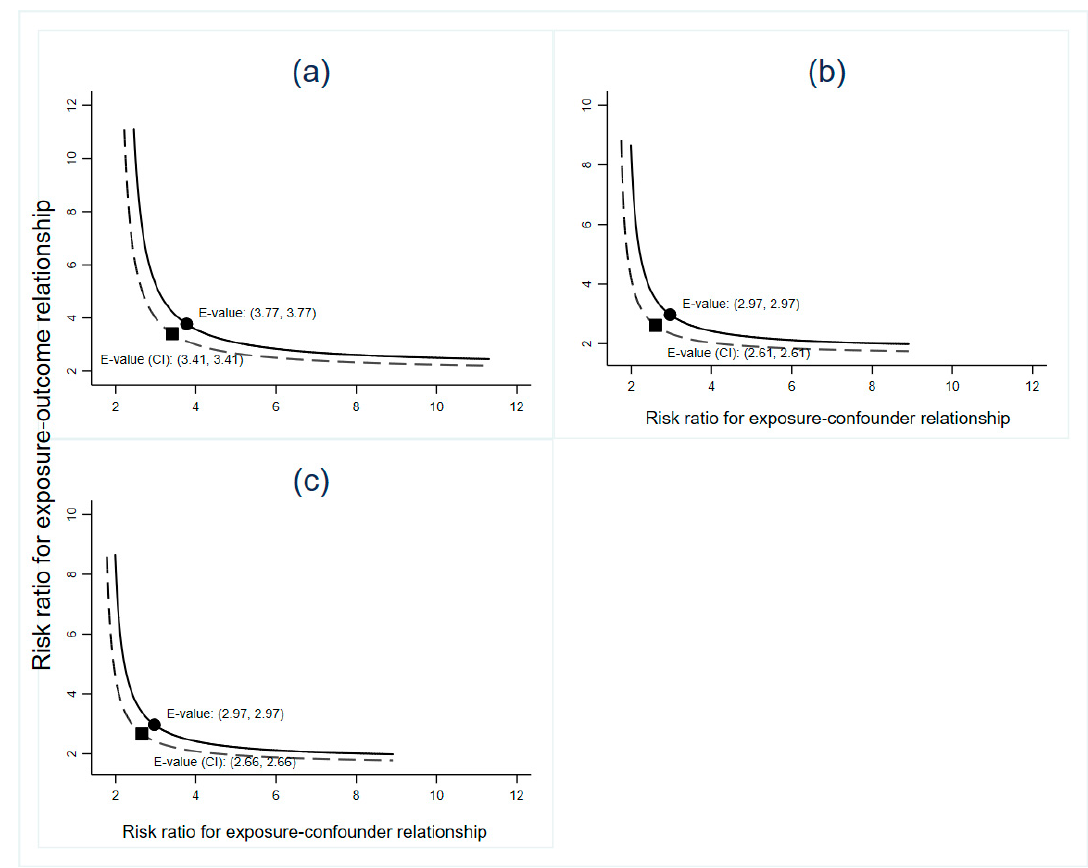
Figure 3. Value of the joint minimum strength of association on the risk ratio scale that an unmeasured confounder would be required to have with FA supplementation (the exposure), and spontaneous abortion (the outcome) to fully explain their observed RR according to initiation time of the supplementation: ( a ) Initiated 3 or more months prior to conception and the observed RR of 0.46 (95% CI: 0.42–0.50); ( b ) initiated 1–2 months prior to conception and the observed RR of 0.56 (95% CI: 0.50–0.62); ( c ) initiated after conception and the observed RR of 0.56 (95% CI: 0.51–0.61). FA, folic acid; CI, confidence interval; RR, risk ratio.